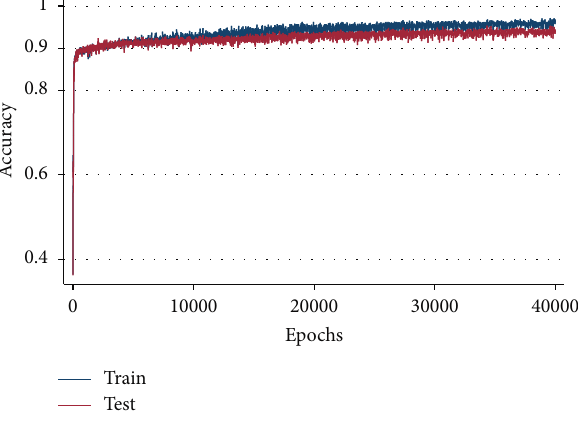
Figure 7: Prediction accuracy of LSTM-CNN model.